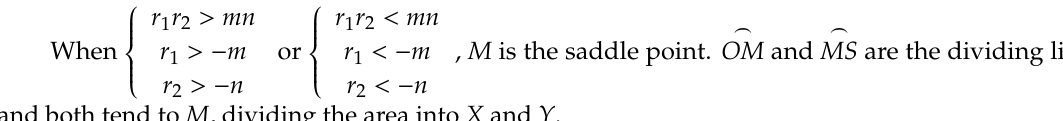
Figure 5. Phase diagram of the two-dimensional system